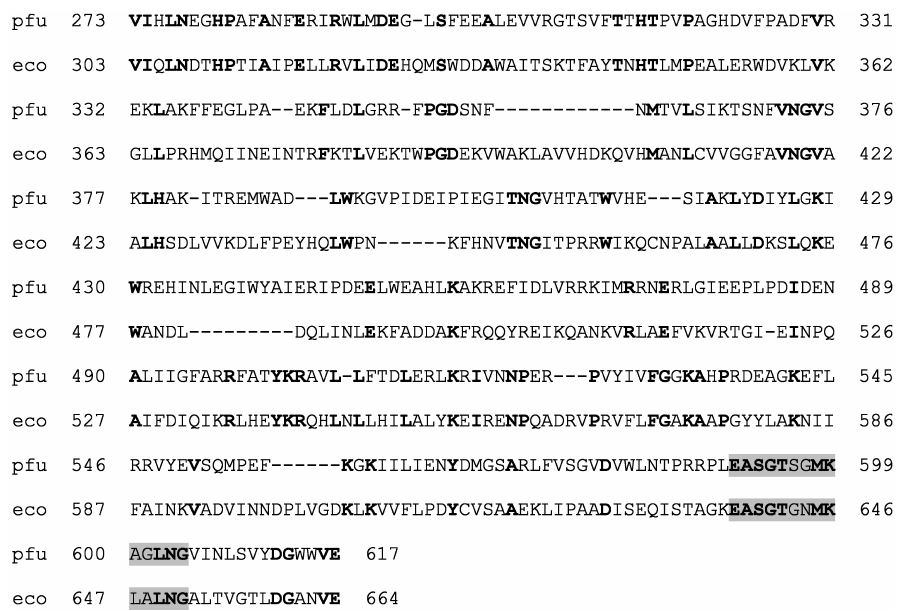
Figure 2. Amino acid sequence alignment of Pyrococcus furiosus (pfu) α -glucan phosphorylase with an Escherichia coli (eco) maltodextrin phosphorylase. Identical amino acids are indi- cated in bold. The conserved pyridoxal phosphate domain resi- dues are